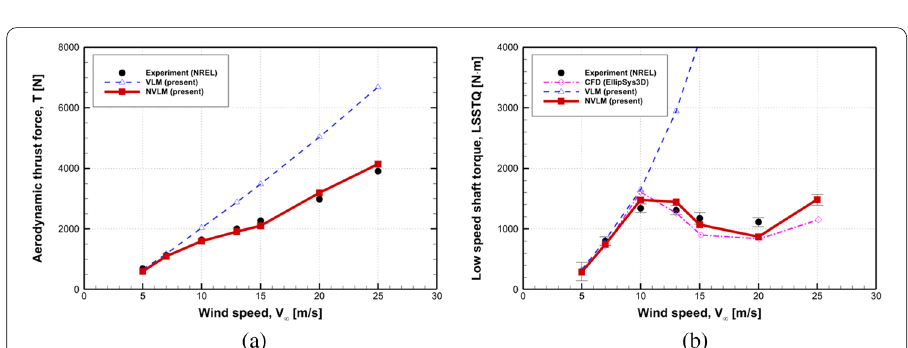
Fig. 12 Comparison of rotor aerodynamic performance depending on wind speed: ( a ) aerodynamic thrust force and ( b ) low-speed shaft torque